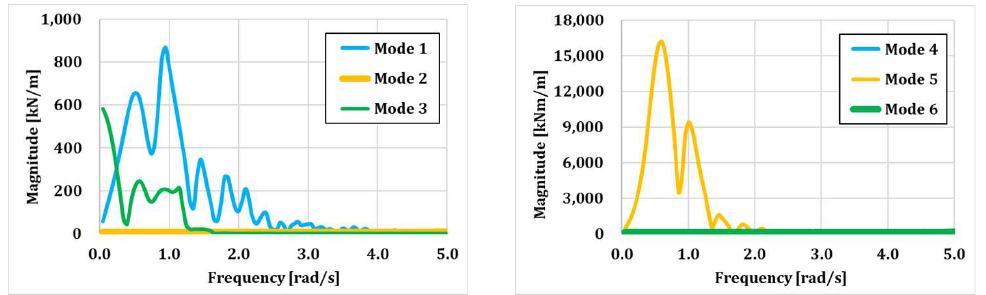
Figure 11. Wave excitation force and moments.